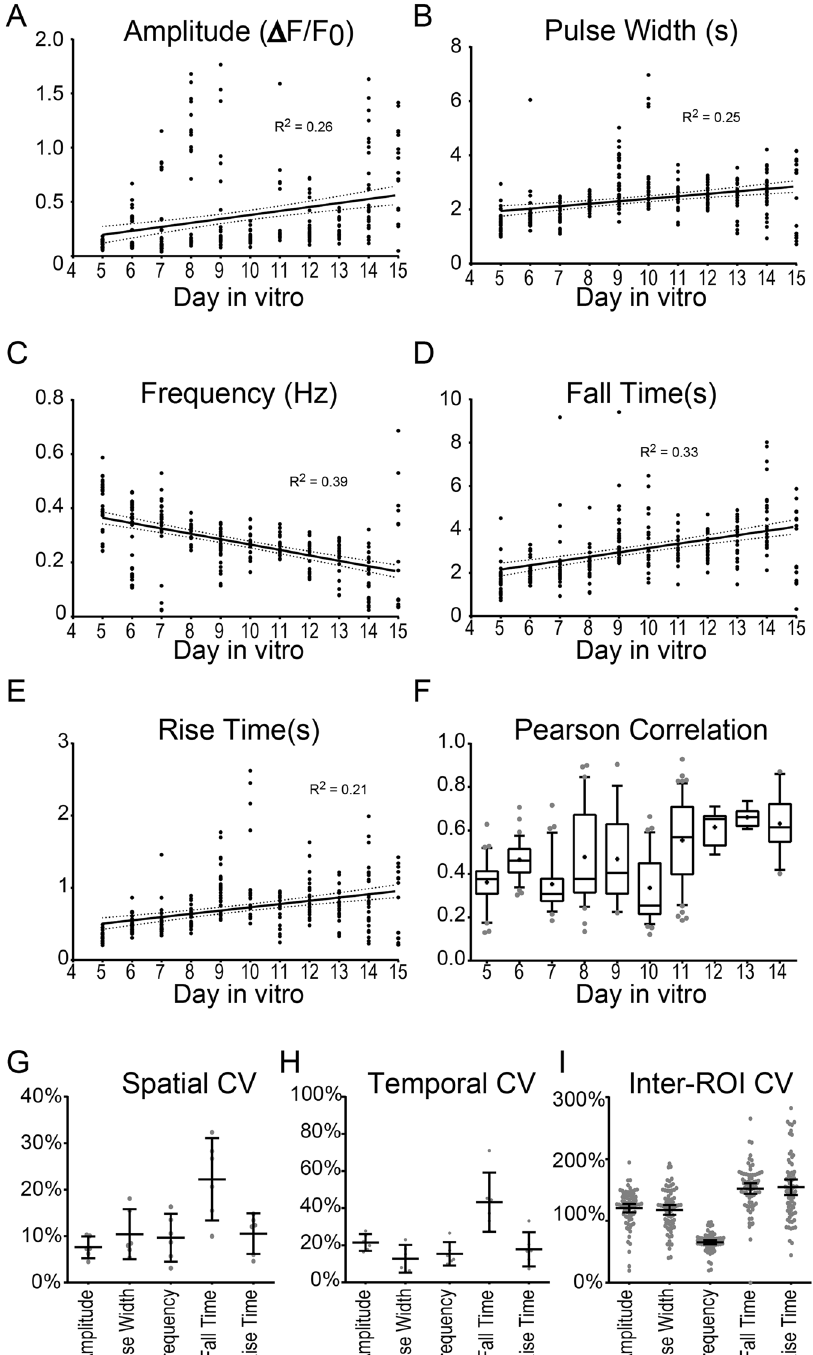
Figure 3. Waveform analysis of neuronal calcium transients. Raw Δ fluorescence traces from neuronal cultures (DIV8–DIV15) were analyzed using the Matlab Signal Processing Toolbox, to extract amplitude ( A ), pulse width ( B ), frequency ( C ), fall time ( D ), and rise time ( E ) for each ROI. ( F ) Synchronization was assessed by calculation of the Pearson correlation coefficient. Plots show averaged values from > 16 acquisitions at each time point taken from 4 independent experiments. Solid lines represent linear regressions with 95% CI (dotted line). ( G – I ) Calcium traces were acquired as above from DIV14 cortical neuron cultures. ( G ) Spatial coefficient of variance (CV) for each of the computed waveform parameters was determined by comparing average values across multiple optical fields within the same well (n = 6 fields per well). ( H ) Temporal CV was determined for each waveform parameter by comparing the average values across serial acquisitions from the same optical field (n = 6 serial captures). ( I ) The coefficient of variation among all ROIs from a given optical field for each of the indicated metrics was calculated for n = 74 separate acquisitions (each dot represents one acquisition). Data are representative of 2 independent neural